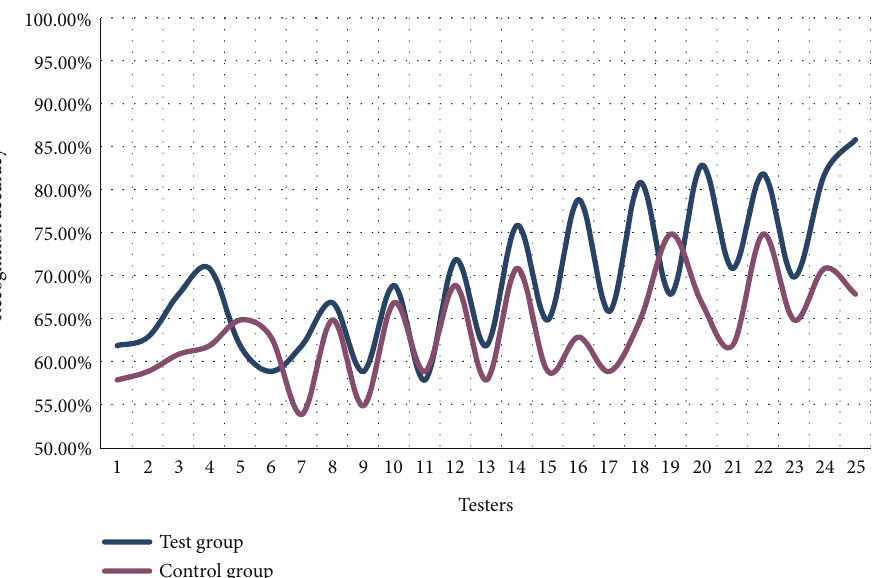
Figure 8: Facial recognition under dynamic recognition conditions.